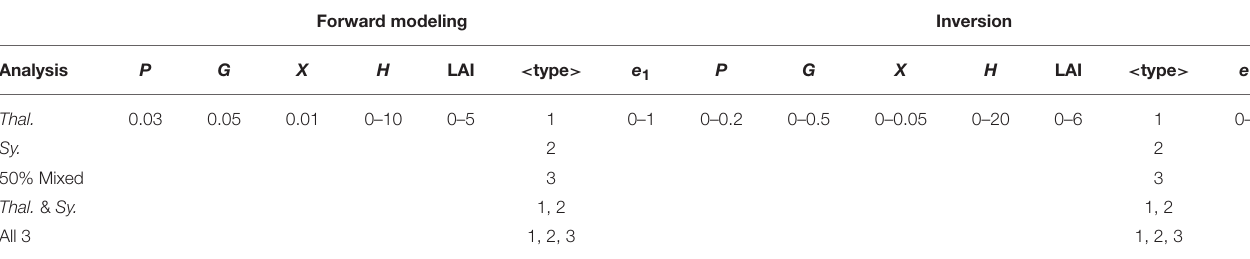
TABLE 2 | Sensitivity analysis design showing range of parameters used for forward modeling and for inversion. Forward